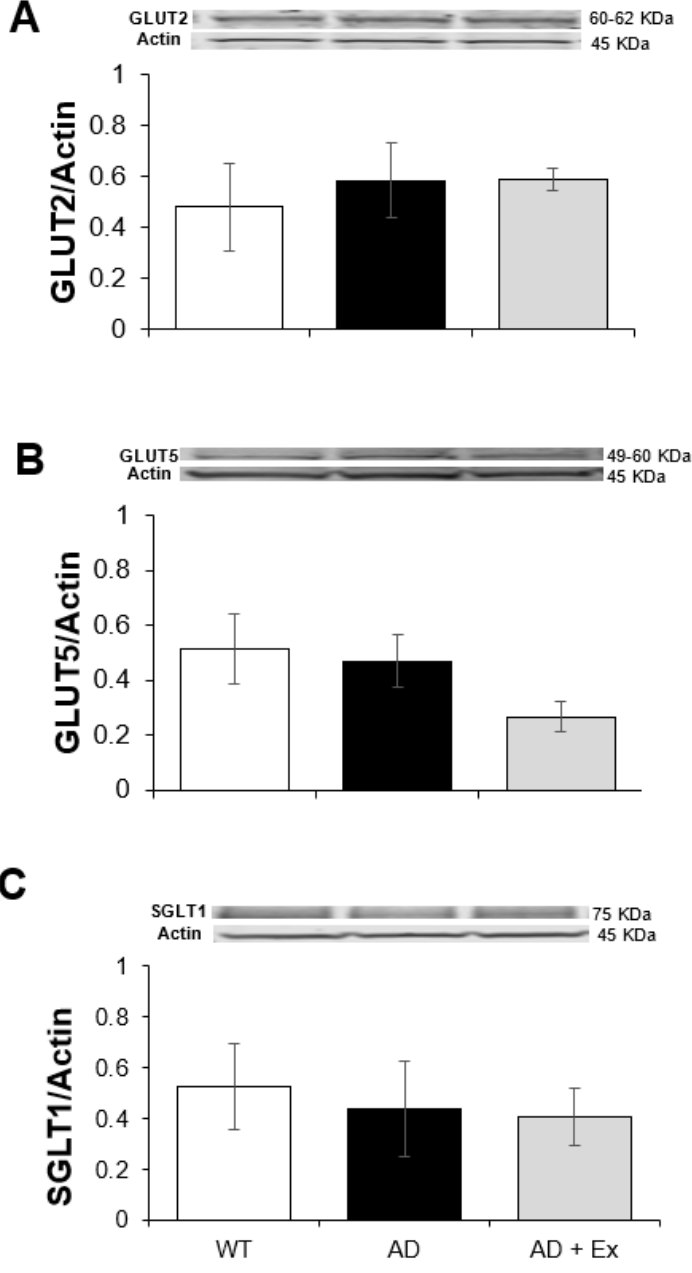
Figure 5. The effects of exercise training on protein expression of the absorptive intestinal transporters in 3xTg-AD mouse jejunum. GLUT2 ( A ), GLUT5 ( B ), and SGLT-1 ( C ) from jejunum of 3xTg-AD mice. Values are reported as mean ± SEM for 6–8 mice per group. GLUT2/GLUT5, glucose transporter; SGLT-1, sodium-glucose cotransporter; AD, Alzheimer’s disease, WT, wild type; Ex, exer- cise.